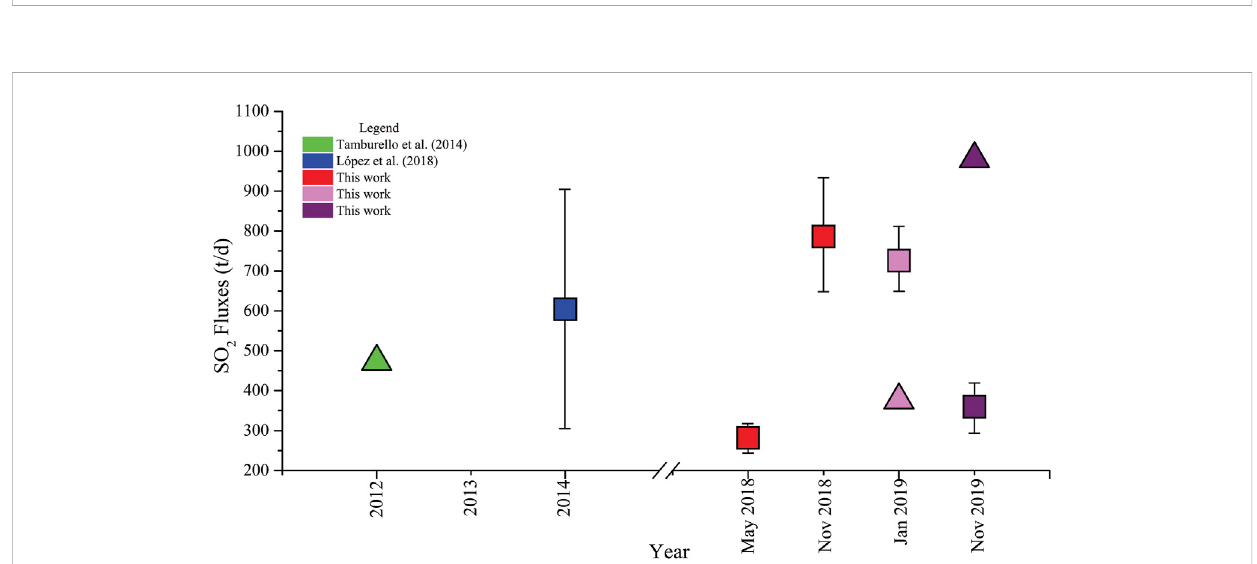
FIGURE 5 SO 2 emission rates (t/d) of Lastarria volcano during the period 2012 – 2019. Filled squares correspond to UV camera measurements (except Lopez etal.,2018,whichwascalculatedonthebaseofUVcameraandDOASdata), fi